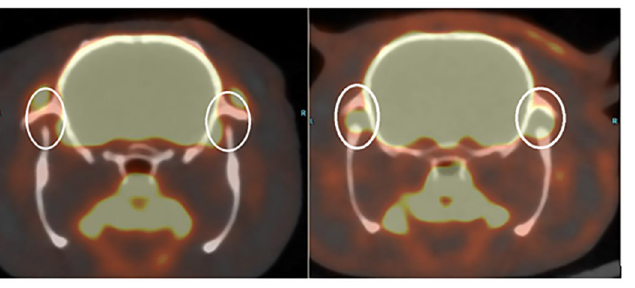
Fig 9. Comparison between signals at TMJs and periarticular muscles in a non-injected rat (left, SUV score = 1.02) and an MIA-injected rat (right, SUV score = 1.91) at day